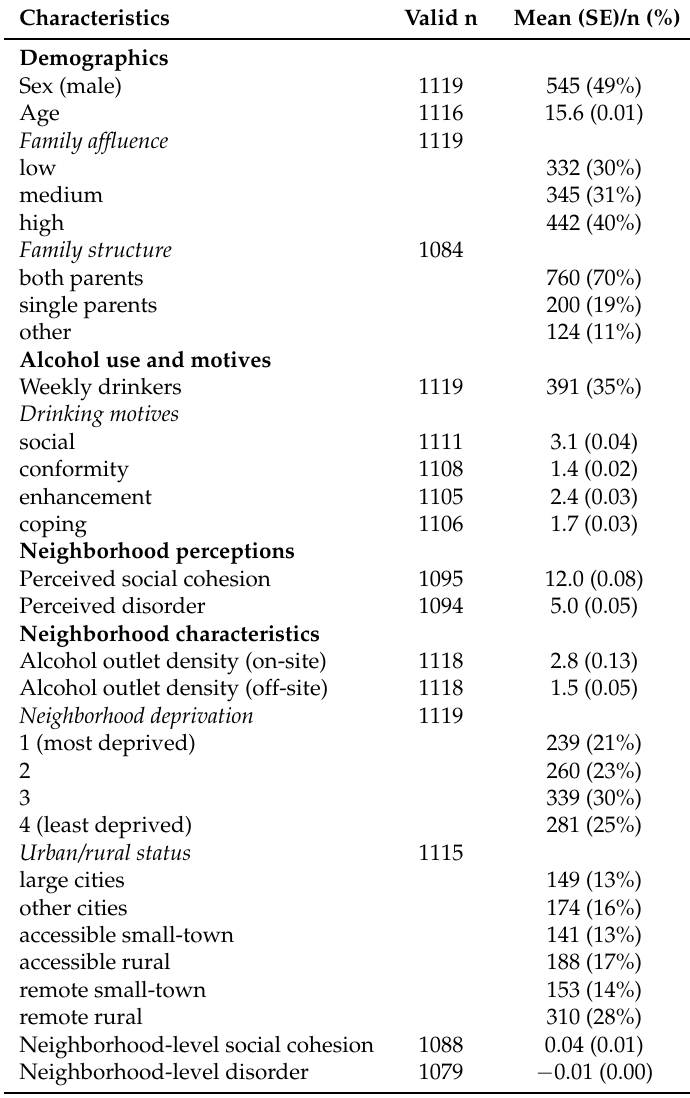
Table 1. Sample characteristics (n = 1119).